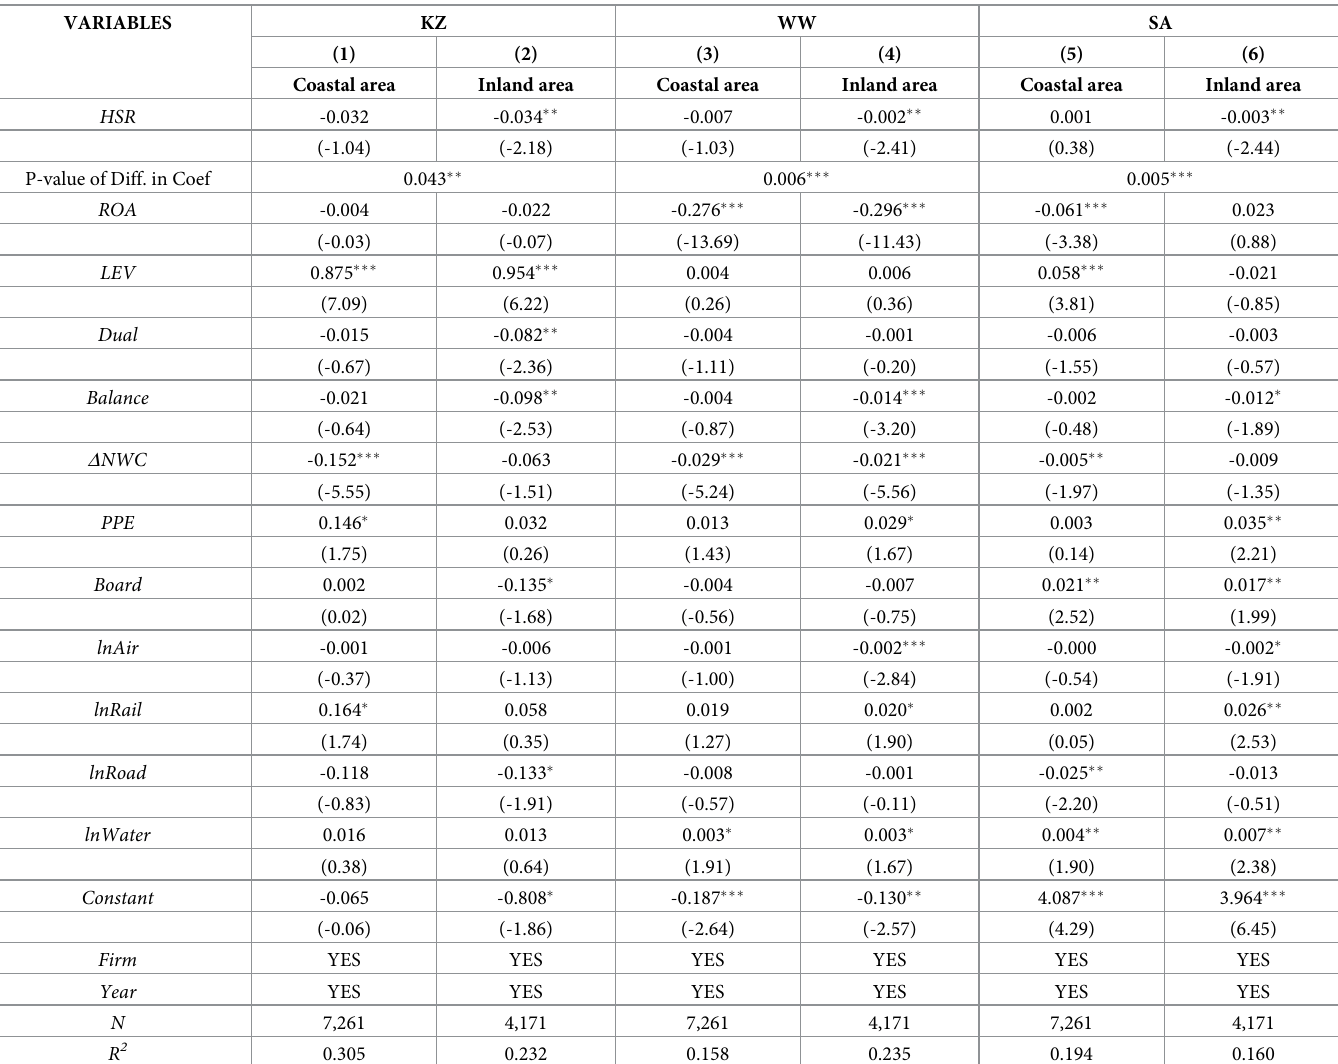
Table 6. Regression results in different